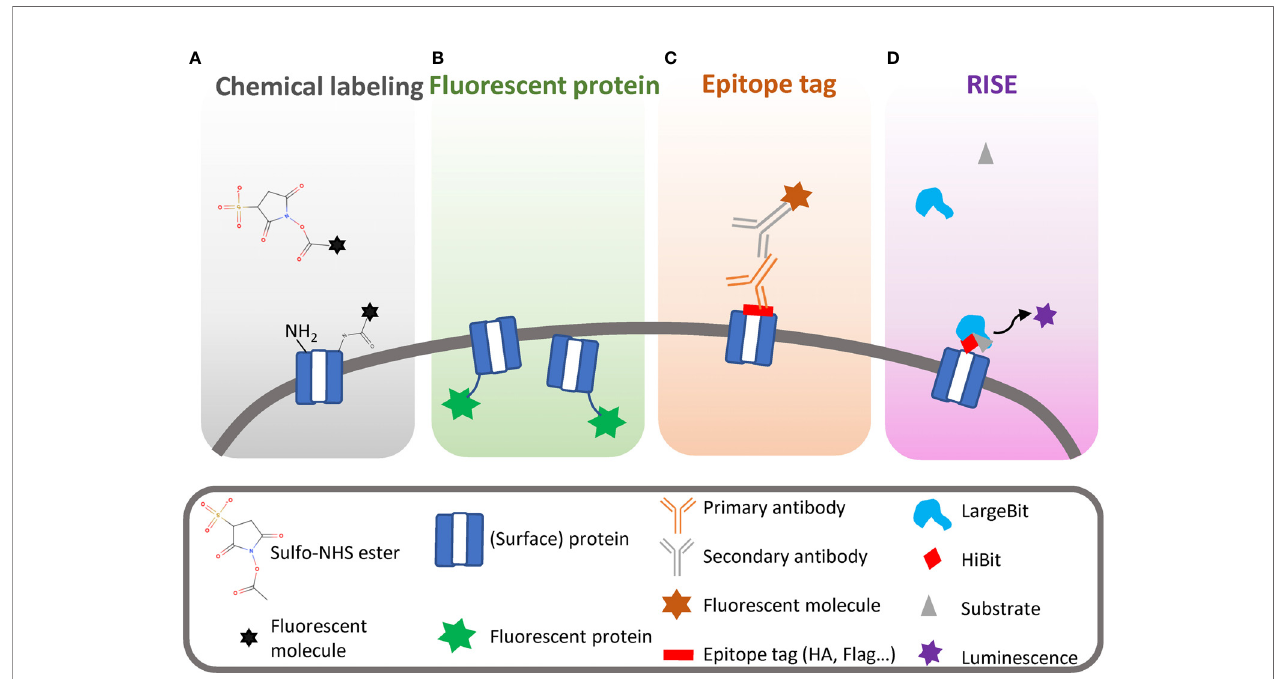
FIGURE 1 | Different strategies to label surface-exposed proteins (SEPs) for visualization and determination. (A) Chemical labeling of SEPs by sulfo-NHS ester and forming covalent bond with an amine group. (B) Fluorescent protein as a reporter attached to target protein, showing both surface-exposed and peripheral proteins. (C) Bioaf fi nity-based strategy to detect surface-exposed protein. (D) RISE-speci fi c detection of surface-exposed proteins using split